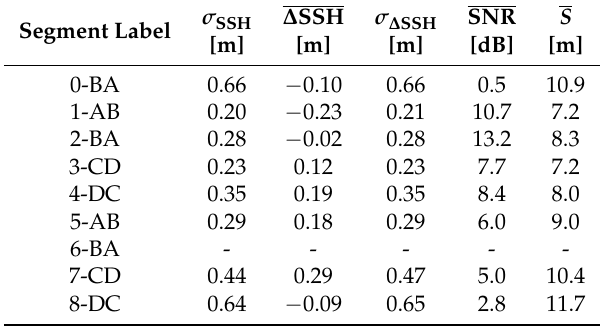
Table 6. Altimetric results for Galileo PRN19 with an integration time of 10 ms (coherent) and 10 s